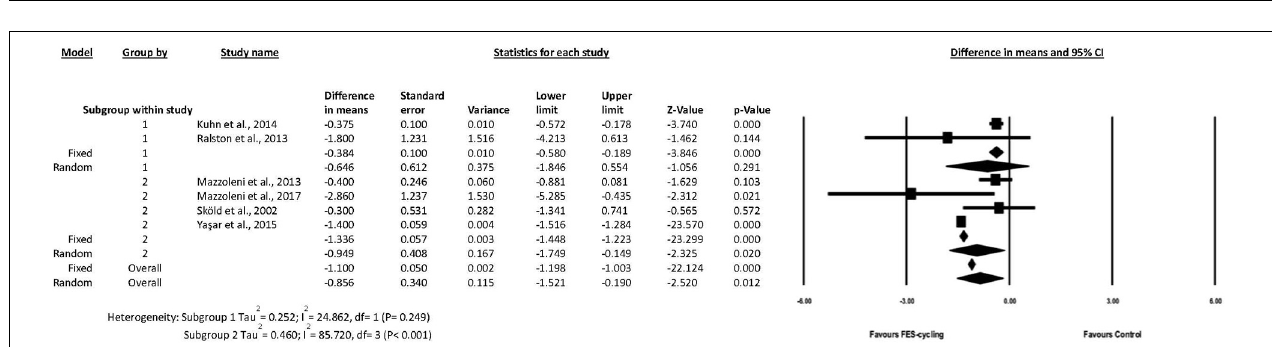
FIGURE 3 | A forest plot of spasticity after one-session of FES-cycling.